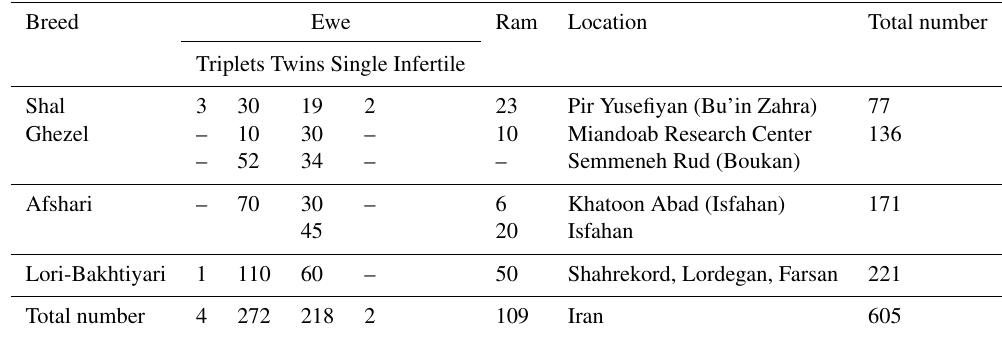
Table 2. Distribution of collected samples from ewes and rams belonging to Iranian sheep breeds. Breed Ewe